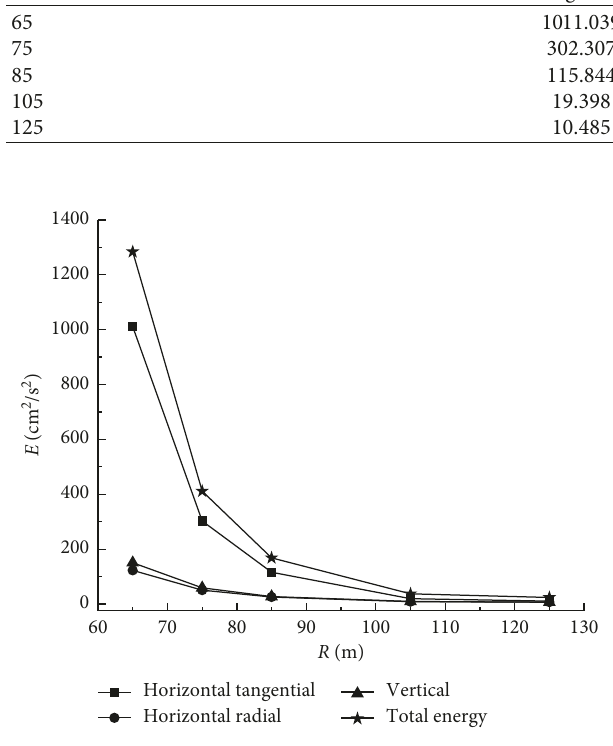
Figure 7: Attenuation laws of energy components along with distance.